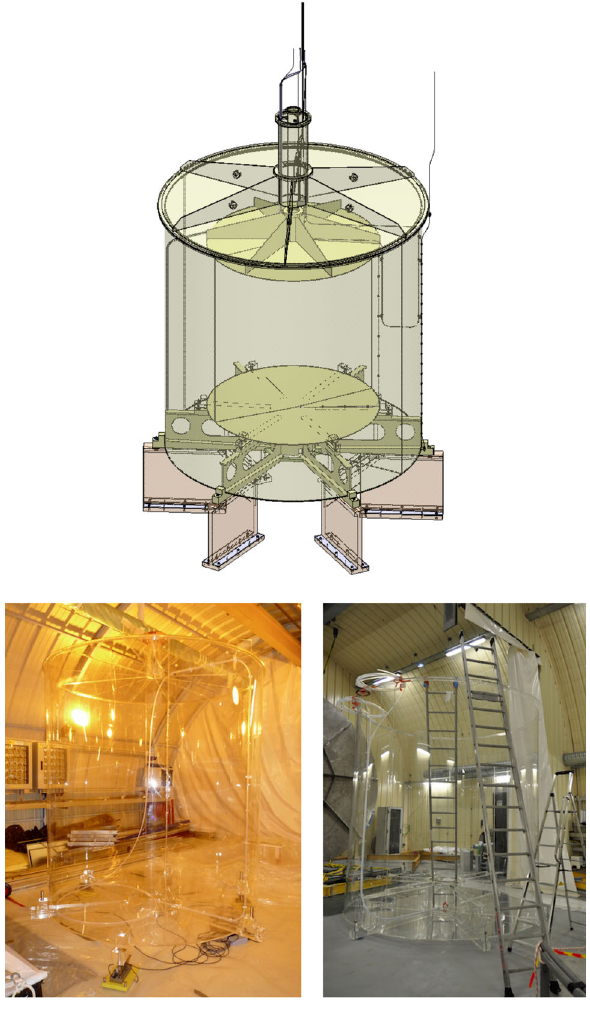
Fig. 2 View of the acrylic vessels (top). The 8mm thick Target vessel (bottom, left) contained 10.3m 3 of Gadolinium-doped scintillator. It was placed inside the 12mm thick Gamma Catcher vessel (bottom, right), filled with organic non-doped scintillator. The ensemble was supported by six massive acrylic